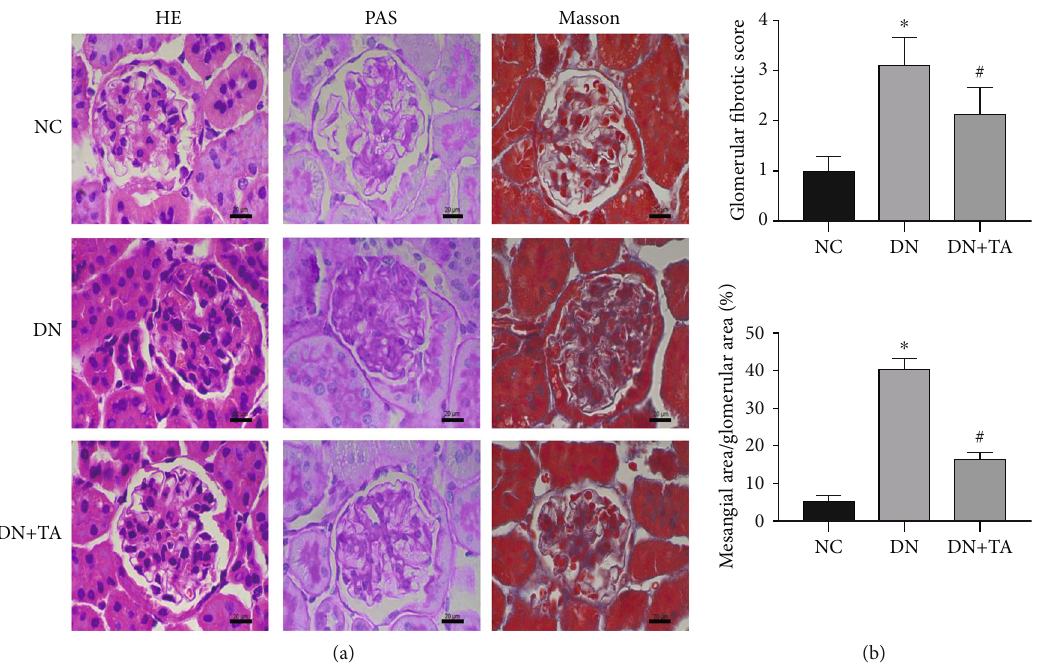
Figure 2: TA alleviated the renal histological alterations in DN. (a) Representative micrographs of HE, PAS, and Masson staining. Original magni fi cation: 400x. (b) Quantitative analyses of mesangial area and Masson staining of glomerular. Data were expressed as mean ± SD ( n = 10 ). ∗ P < 0 : 05 versus NC group; # P < 0 : 05 versus DN group.